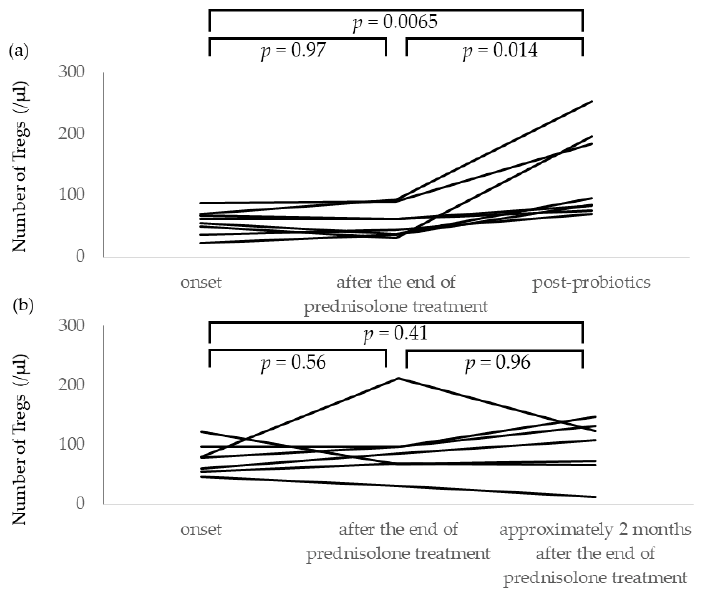
Figure 4. Changes in Treg frequencies after administration of C. butyricum MIYAIRI as a probiotic to patients with INS. Treg frequencies were measured at three time points: at the onset of INS, immediately after the end of prednisolone administration following induction of initial remission, and 1.5 to 2 months after starting probiotic administration following prednisolone cessation. ( a ) Probiotic-treated group: There was a significant increase in the number of Tregs after comparing with before probiotic treatment. ( b ) Non-probiotic treatment group: in the seven patients in the non-probiotic treatment group, there was no statistically significant increase in the number of Tregs at onset, immediately after the end of prednisolone treatment, and approximately 2 months after the end of prednisolone treatment.